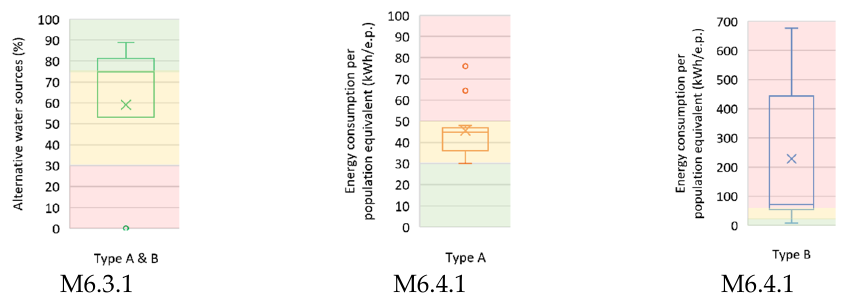
M5.2.1 Figure 9. Results of the validation applied to the wastewater utilities: objective 5. Under objective 6 (protection of the environment), aspects related to water pollution are still very dependent on qualitative information because quantification of volume, du- ration, and the number of untreated discharges is lacking (criterion 6.1). Knowledge about untreated discharges is insufficient because measurement devices are not in place or rec- ommended by responsible authorities (M6.1.1). Only one utility has an implemented plan for control of untreated discharges (M6.1.2). For wastewater treatment (criterion 6.2), type A utilities often do not have the infor- mation on the number of households and thus very few respond to the regulator (Figure 3); in the validation, the three participating utilities have results of good. For M6.2.2, all util- ities in the validation have a result of good. In terms of pollution prevention and control (criterion 6.3), the metrics on alternative water sources (M6.3.1) and on the transition to low carbon energy (M6.3.2) are valued as